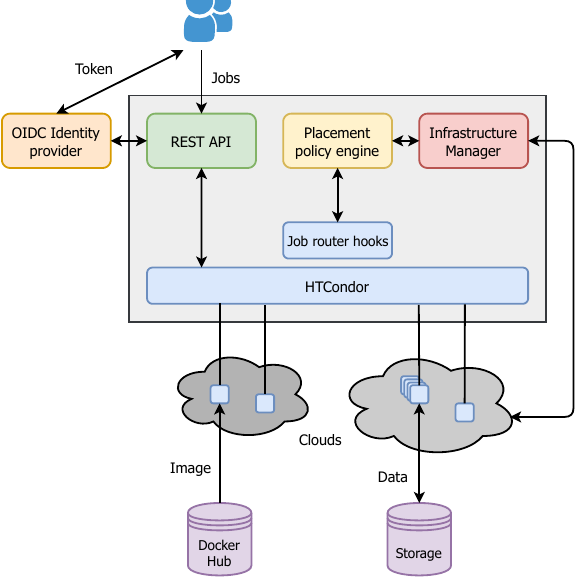
Fig. (cid:21) . An overview of the Prominence